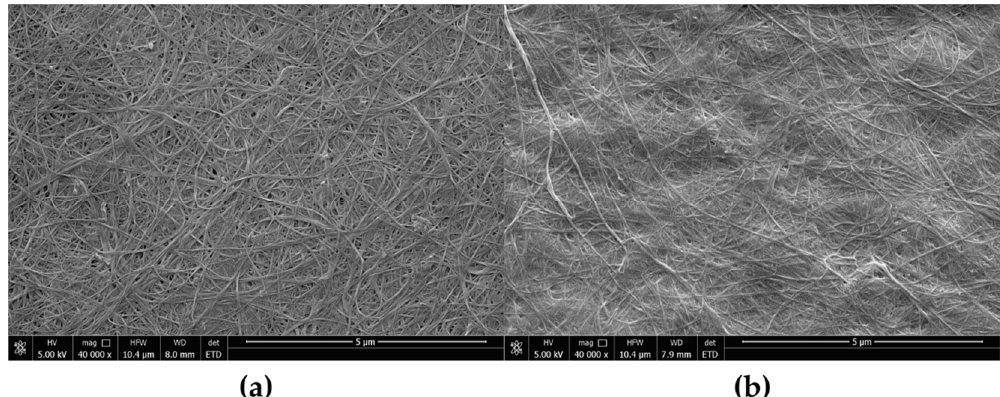
Figure 8. Scanning electron microscope images of BNC synthesised by K. hansenii SI1 in SH medium supplemented with ( a ) ethanol and ( b ) lactic acid; the images were recorded at a magnification of 40,000× (bar—5 µm).